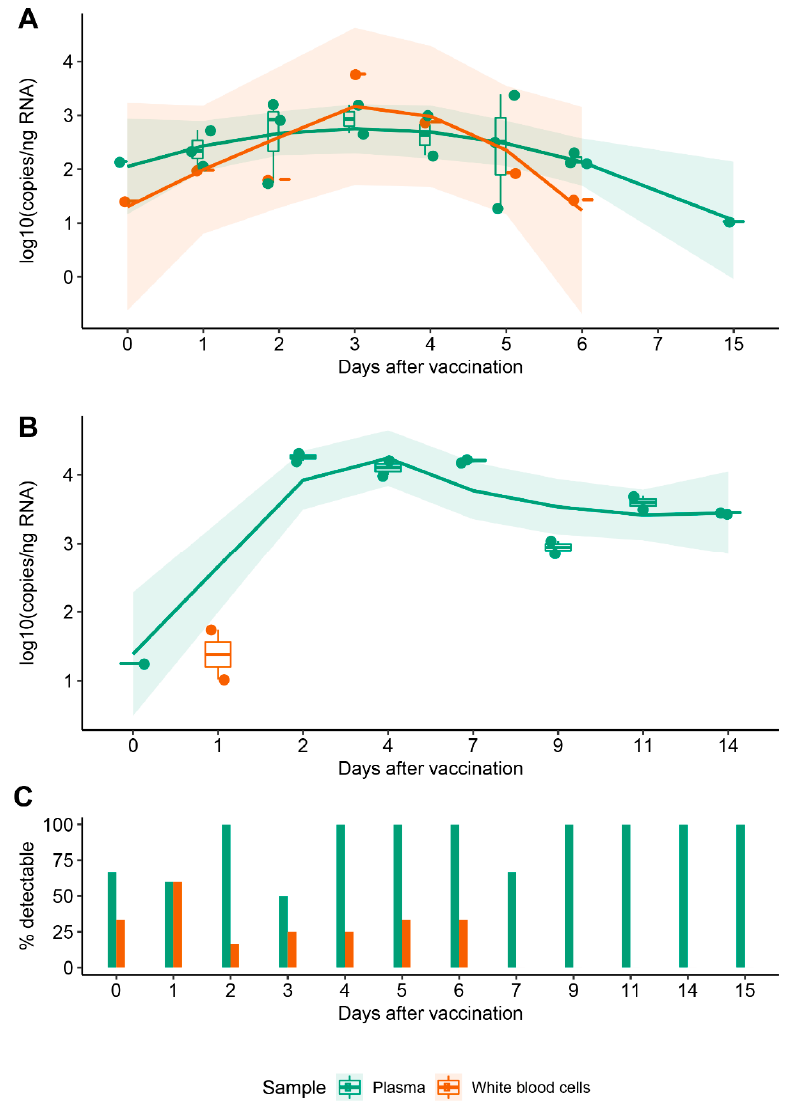
Figure 1. Persistence of synthetic mRNA in blood following vaccination. ( A ) Distribution of synthetic mRNA copy number normalised to the equivalent quantity of input RNA in a cohort of 16 individuals; each point represents an independent biological sample. ( B ) Distribution of synthetic mRNA copy number normalised to the equivalent quantity of input RNA in a single individual; technical replicates are shown for all timepoints analyzed. For ( A , B ), trendlines were fitted using locally estimated scatterplot smoothing (LOESS) regression to observe variations of mRNA in plasma (green) and cellular fraction (orange) in the days following vaccination. Only data corresponding to copy numbers above LoQ = 10 are shown. ( C ) Cumulated likelihood of detecting synthetic mRNA in plasma and cellular fractions across subjects and days following